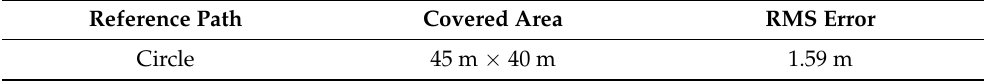
Table 5. The positioning results without estimation designs in the